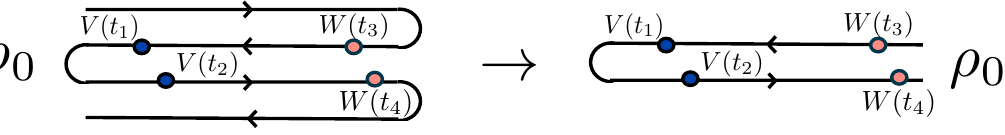
Figure 10 . The con(cid:12)guration ~ G